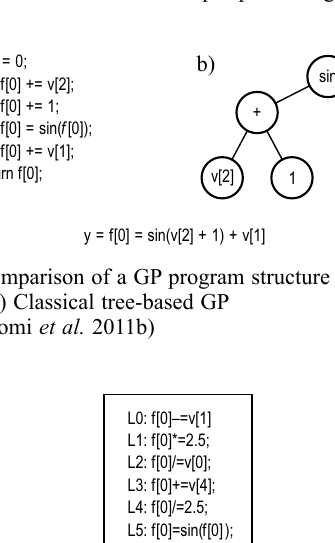
Fig. 2. GP in the context of the input-processing-output model